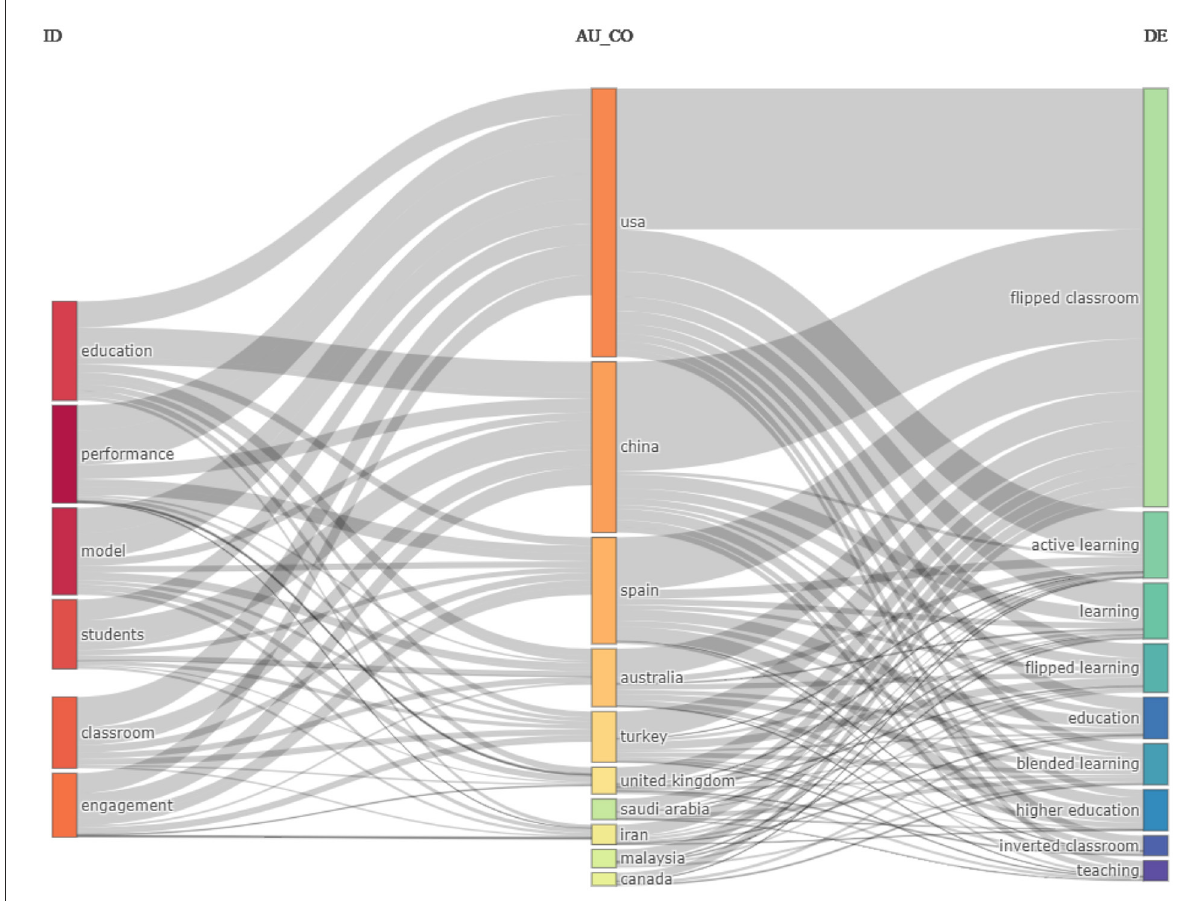
FIGURE5 Three-Fields Plot between keywords plus (left field), the most productive countries (middle field) and the authors’ keywords (right field). Source: Bibliometrix in R.